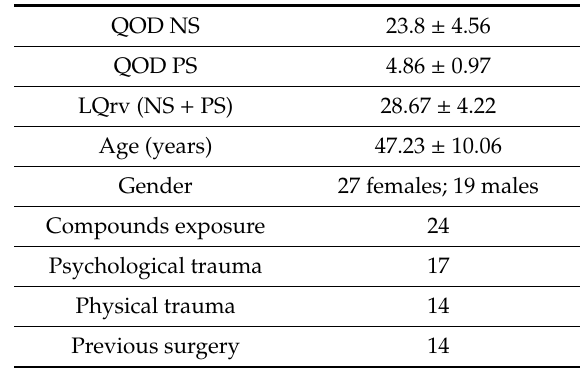
Table 1. Olfactory-related quality of life and clinical-anamnestic aspects of Multiple Chemical Sensitivity